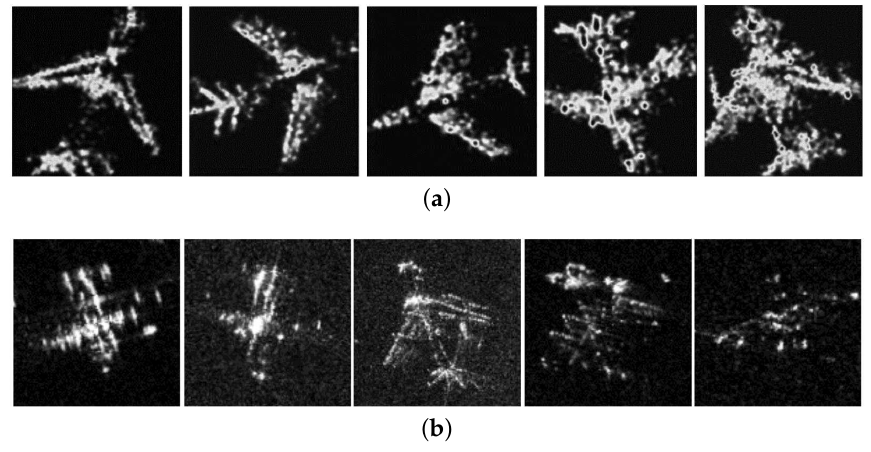
Figure 2. TerraSAR-X image slices. ( a ) 1.0 m resolution images of the same type of aircraft; ( b ) 0.5 m resolution images of different types of